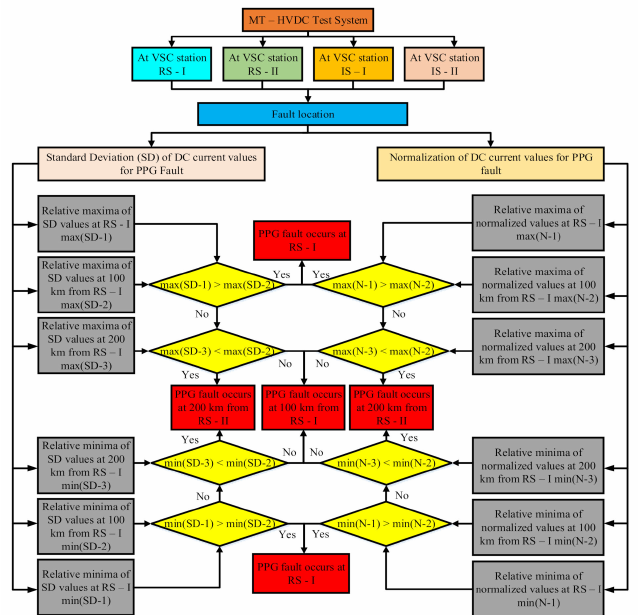
Figure 5. An algorithm for PPG fault location finding based on SVM, using supported features of standard deviation and normalization of DC